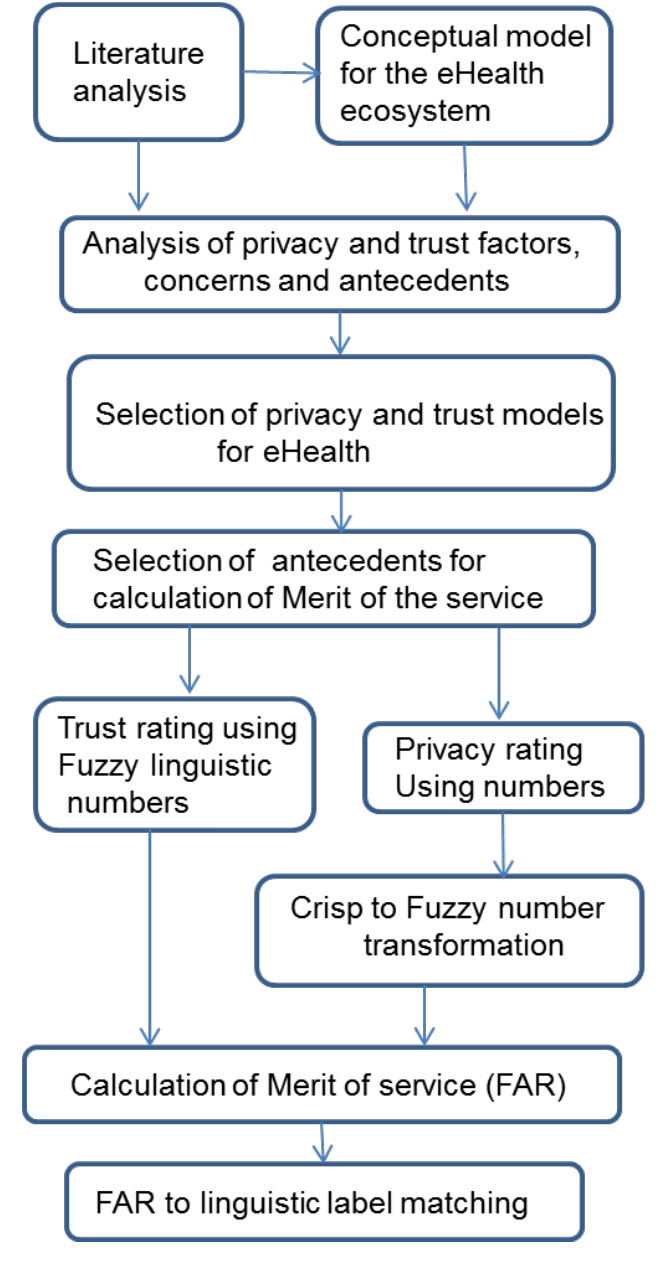
Figure 1. Phases of the study.